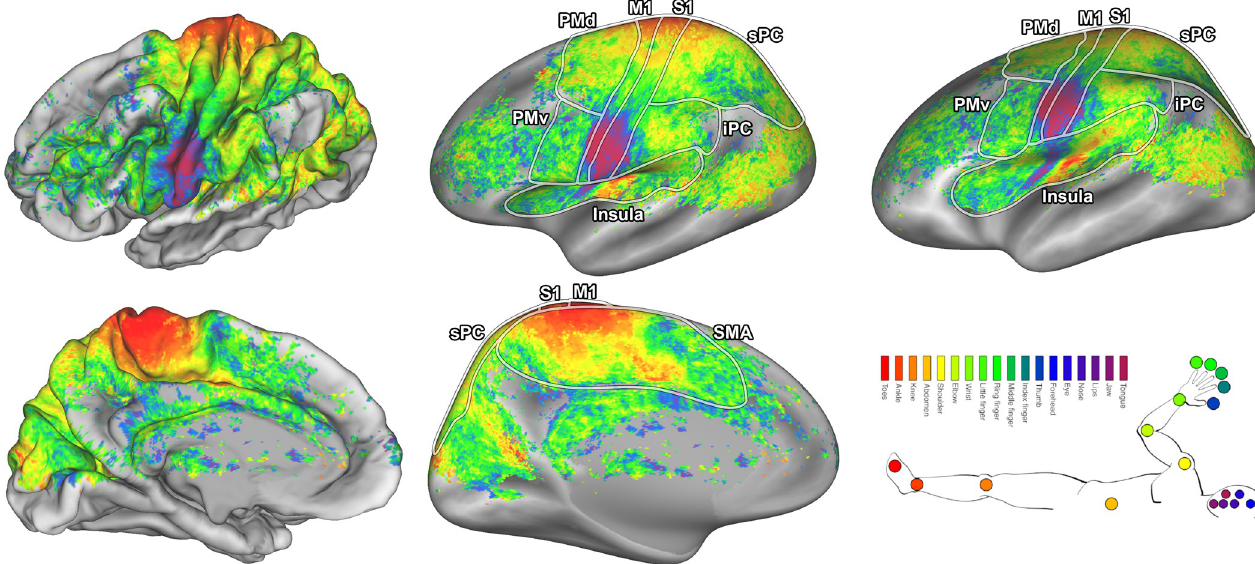
Fig 3. pRF center maps. The pRF centers are shown on an average subject pial surface (left) and inflated surface (right) from a lateral point of view (top) and medial point of view (bottom). Colors indicate the body part that was estimated as the pRF center. The ROIs are denoted by the lines drawn on the surfaces: primary motor cortex (M1), primary somatosensory cortex (S1), supplementary motor area (SMA), dorsal premotor cortex (PMd), ventral premotor cortex (PMv), Insula/Sylvian fissure (Insula), inferior parietal cortex (iPC), and superior parietal cortex (sPC).